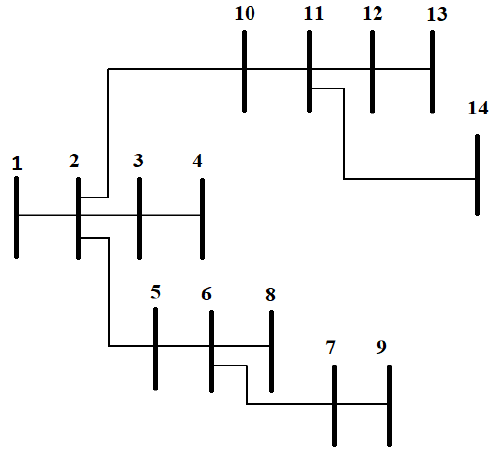
Figure 3. Single line diagram of 14-bus RDS. Table 1. Line and load data of 14-bus RDS. Bus No.